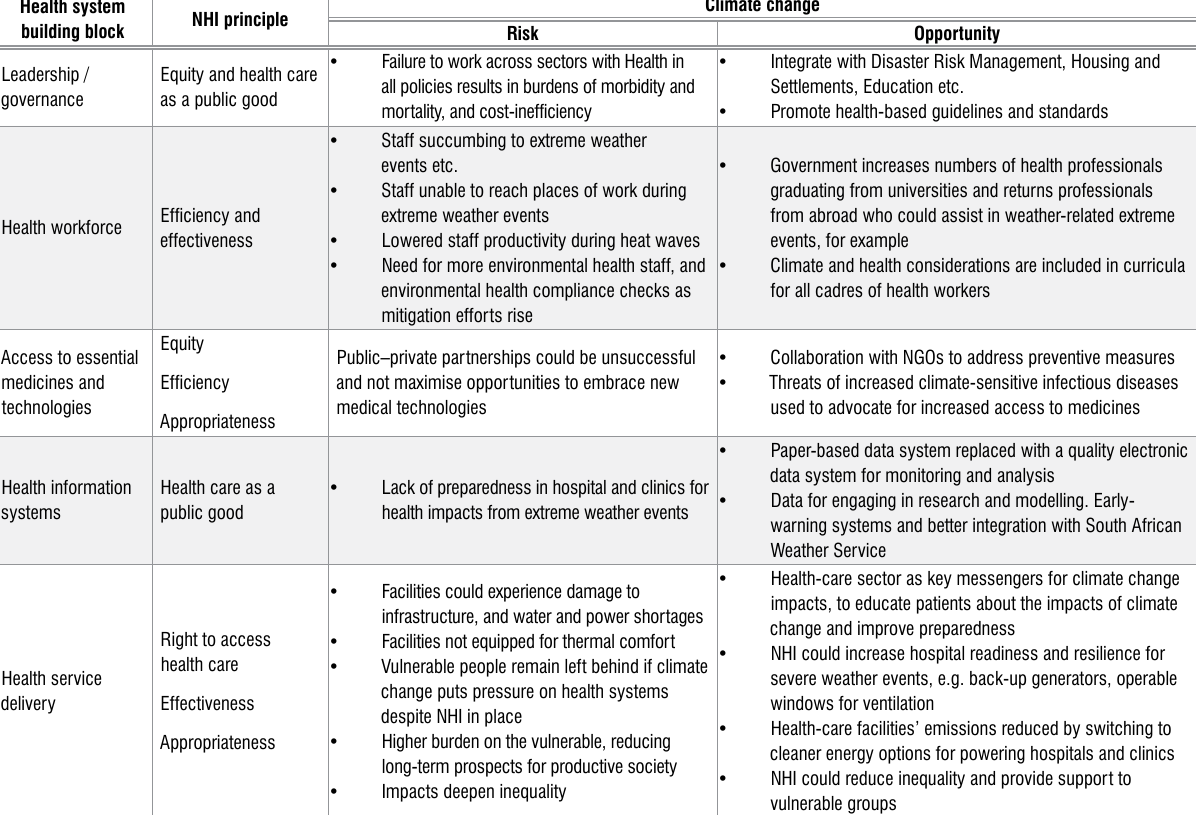
Health system building blocks, principle or element of National Health Insurance (NHI) and climate change: Identifying risks and opportunities to prepare and mitigate